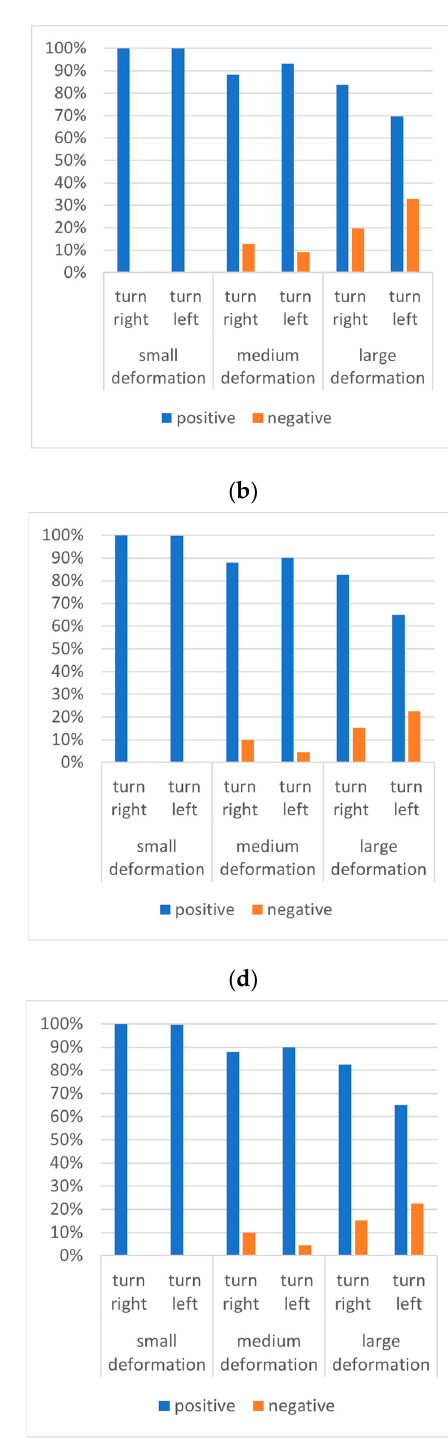
Figure 15. Anaglyphs created by overlaying the right-sided image after transformation onto the left one as a result of selecting a set of 10 matching points (variant W1) rotated to the right. Images of the marker grid: ( a ) Small deformation; ( b ) medium deformation; ( c ) large deformation.